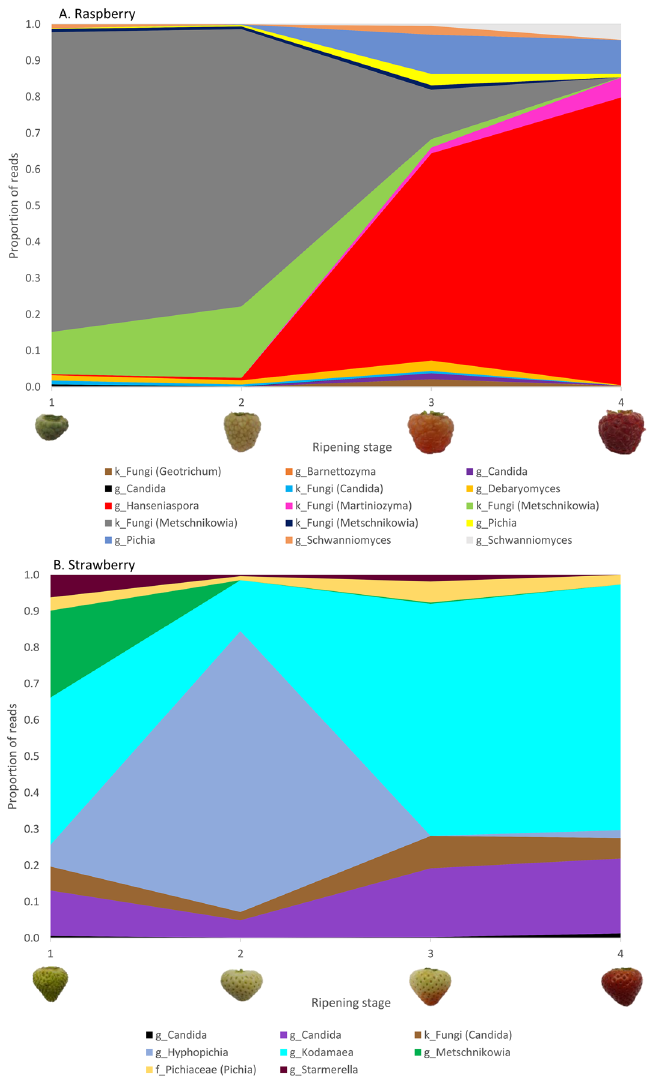
Figure 6. Dynamics of changes in the proportion of budding yeast indicator phylotypes. Mean proportion of reads for the Saccharomycetales budding yeast indicator phylotypes that are significantly overrepresented on ( A ) raspberry and ( B ) strawberry ( P < 0.04) across the four ripening stages (1, unripe/green fruit; 2, de-greening fruit; 3, ripening fruit; and 4, fully ripe/harvest fruit). Indicator phylotypes are reported to the taxonomic level assigned: lower case letter refers to the taxonomic hierarchy of respective taxa (g = genus; f = family; k = kingdom). Where possible, assignment to genus taxonomic levels is shown in parentheses from matches to deposits in Genbank with > 97% homology identified by manual Blast